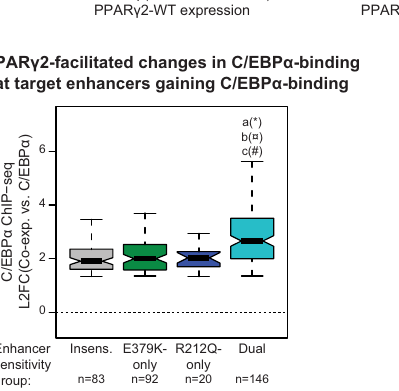
functional PPAR γ binding sites, where PPAR γ acts as a key driver of enhancer activity. To investigate how the E379K and R212Q mutations affect the ability of PPAR γ to bind to chromatin and activate enhancers, we repeated the PPAR γ , H3K27ac, and MED1 ChIP-seq for the PPAR γ mutants. Interestingly, the mutations did not affect overall PPAR γ association with chromatin but selectively compromised PPAR γ